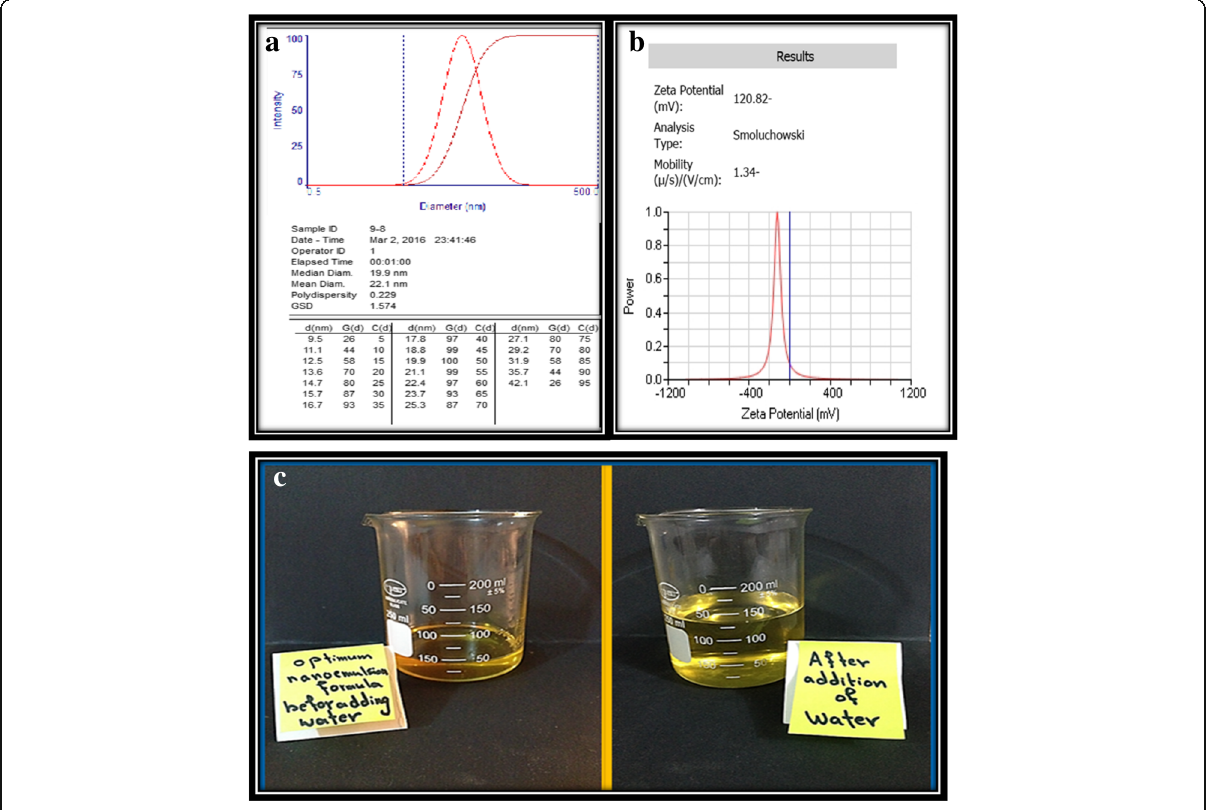
Fig. 10 Characteristics of optimum nanoemulsion formula (NE-4) showing: a Droplet size distribution, b Zeta potential, and c Physical